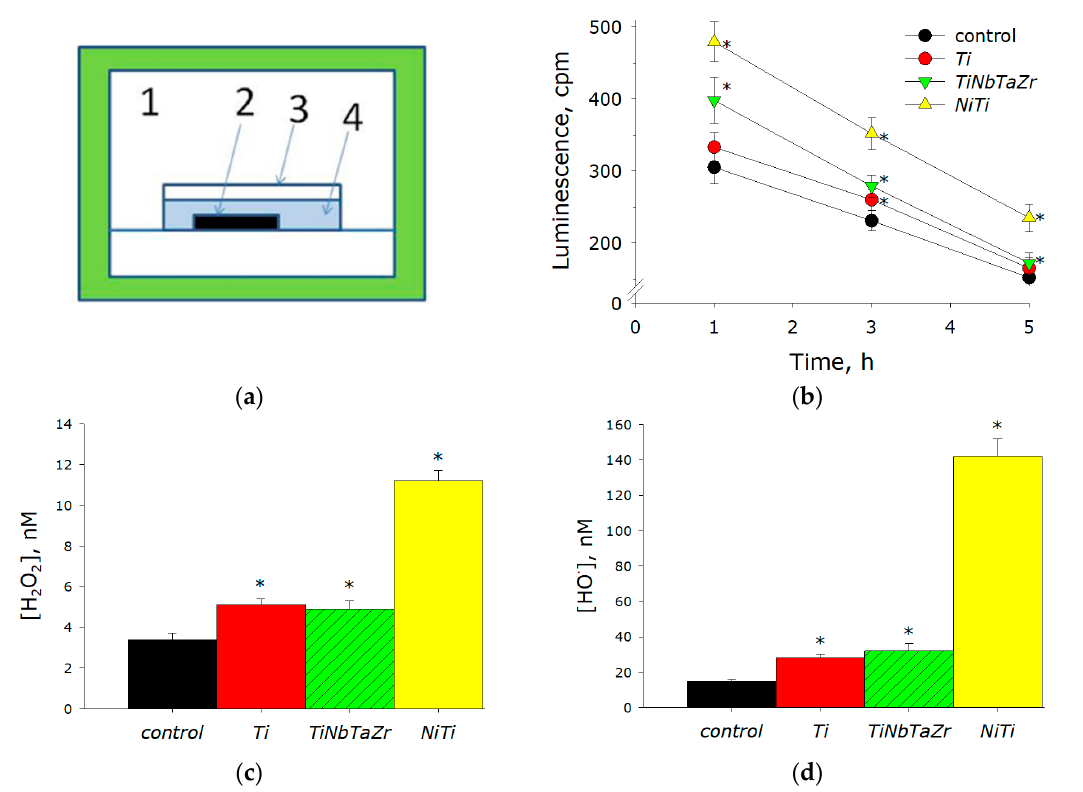
Figure 4. Influence of Ti-20Nb-10Ta-5Zr on ROS and LRPS rate production: ( a ) Scheme of experi- mental chamber (1—thermostat, 2—Ti-20Nb-10Ta-5Zr alloy, 3—Petri dish, 4—saline solution); ( b ) influence of Ti-20Nb-10Ta-5Zr alloy on LRPS rate production (120 min, 40 °C); ( c ) influence of Ti- 20Nb-10Ta-5Zr alloy on H 2 O 2 rate production (120 min, 40 °C); ( d ) influence of Ti-20Nb-10Ta-5Zr alloy on generation of hydroxyl radicals (2 h, 80 °C). *— p < 0.05 vs. solution without metal samples, two sample two-tailed t -test.